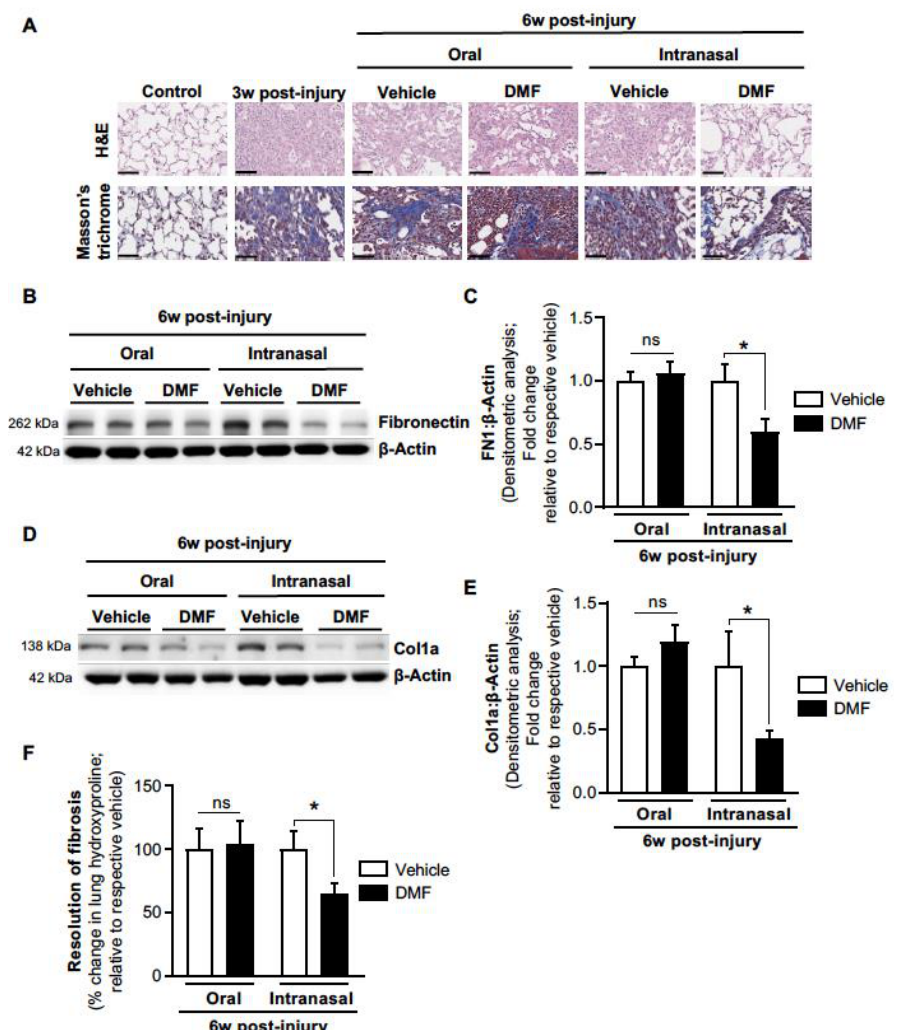
Figure 3. Schematic diagram illustrating age-dependent persistent lung fibrosis and treatment pro- tocol. C57BL/6J aged (18 months) female mice received an intratracheal instillation of bleomycin (0.02875 U/mouse). DMF was administered daily by oral gavage (240 µg/150 µL in sterile PBS/mouse) or intranasal instillation (80 µg/50 µL in sterile PBS/mouse) from 3 – 6 weeks post-injury.